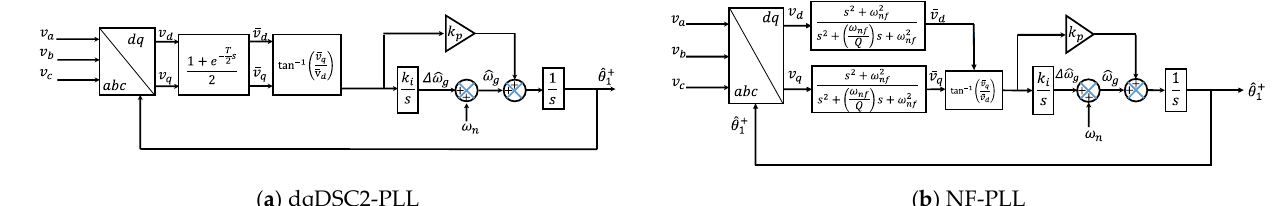
Figure 8. Block diagrams of the ( a ) dqDSC2-PLL, ( b ) NF-PLL. Table 1. The controller parameters. Parameters